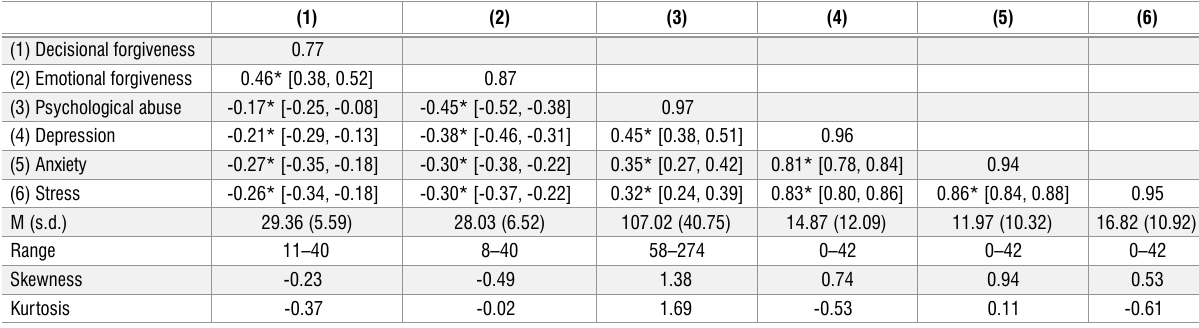
Descriptive statistics, internal consistency estimates and zero-order correlations among primary study